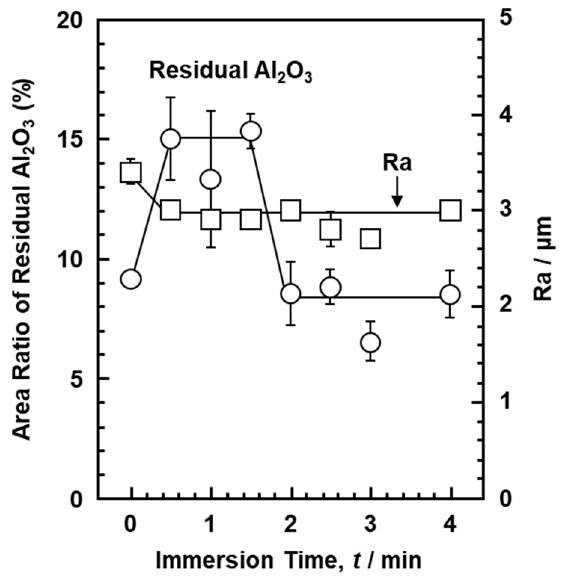
Figure 9. Changes in area ratio of residual Al 2 O 3 and surface roughness ( Ra ) as functions of immersion time in hydrofluoric acid aqueous solution.